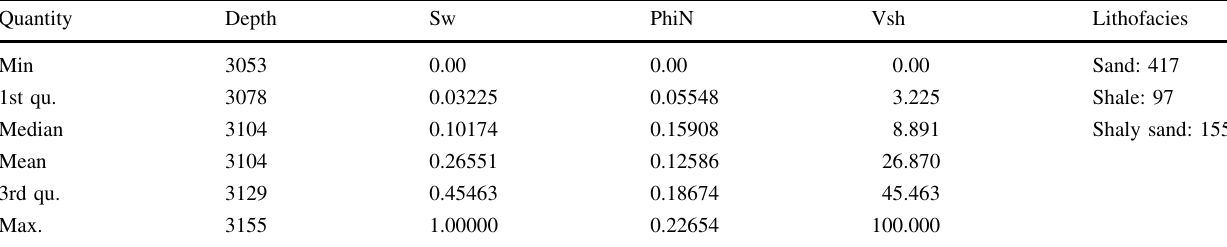
Table 1 Summary of well log interpretations and core-based discrete lithofacies distribution for the well under study Quantity